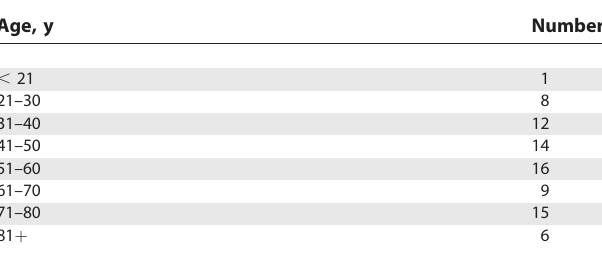
Table 1. Patients Recruited by Age Group Age,